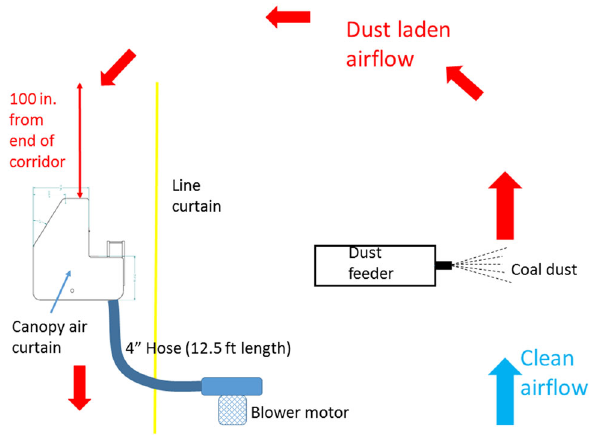
Fig. 3 Layout of the CAC testing in the continuous miner gallery